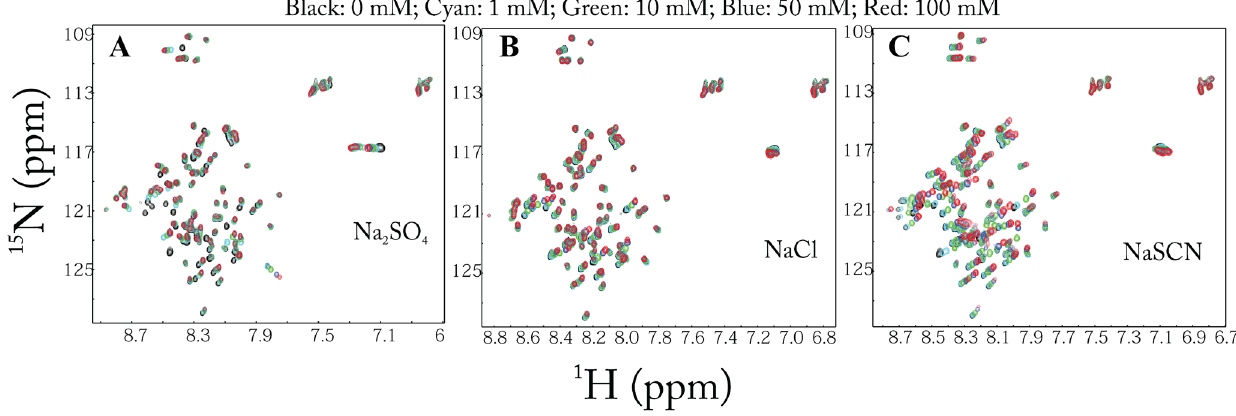
Figure 16. Anion-binding as monitored by NMR. Superimposition of two-dimensional 1 H– 15 N NMR HSQC spectra of the entire cytoplasmic domain of ephrin-B2 at a protein concentration of 300 µM (pH 4.0) at 25 ° C, in the absence and in the presence of Na at varying salt